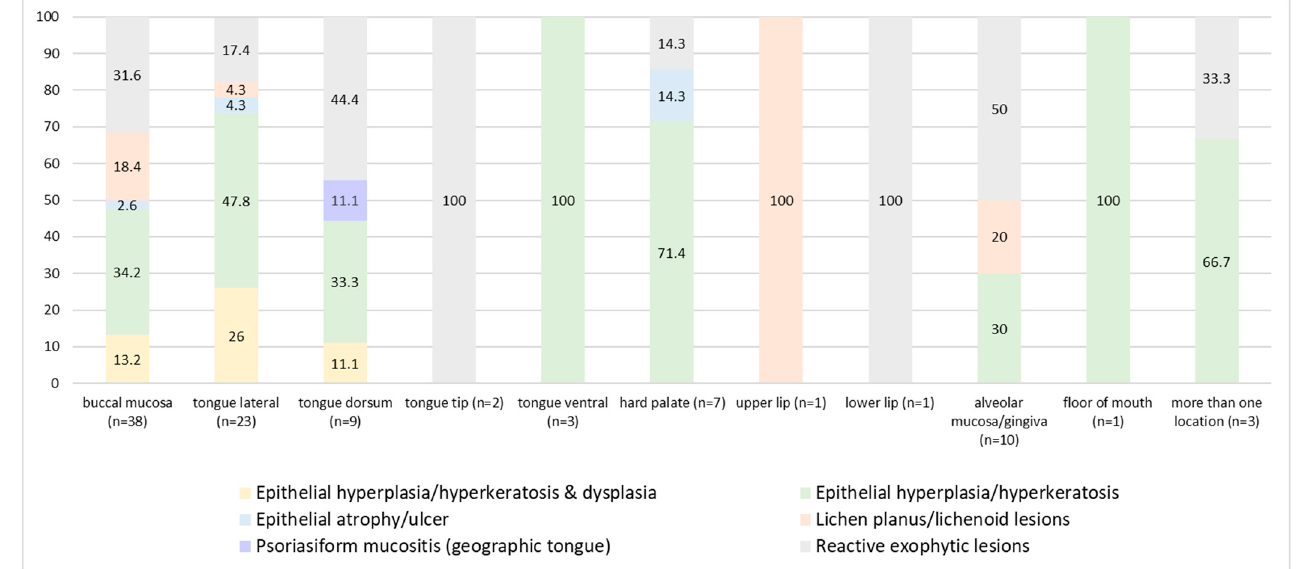
Figure 3. Distribution (%) of microscopic diagnoses in the study group (N = 98) as a factor of location in the oral cavity .